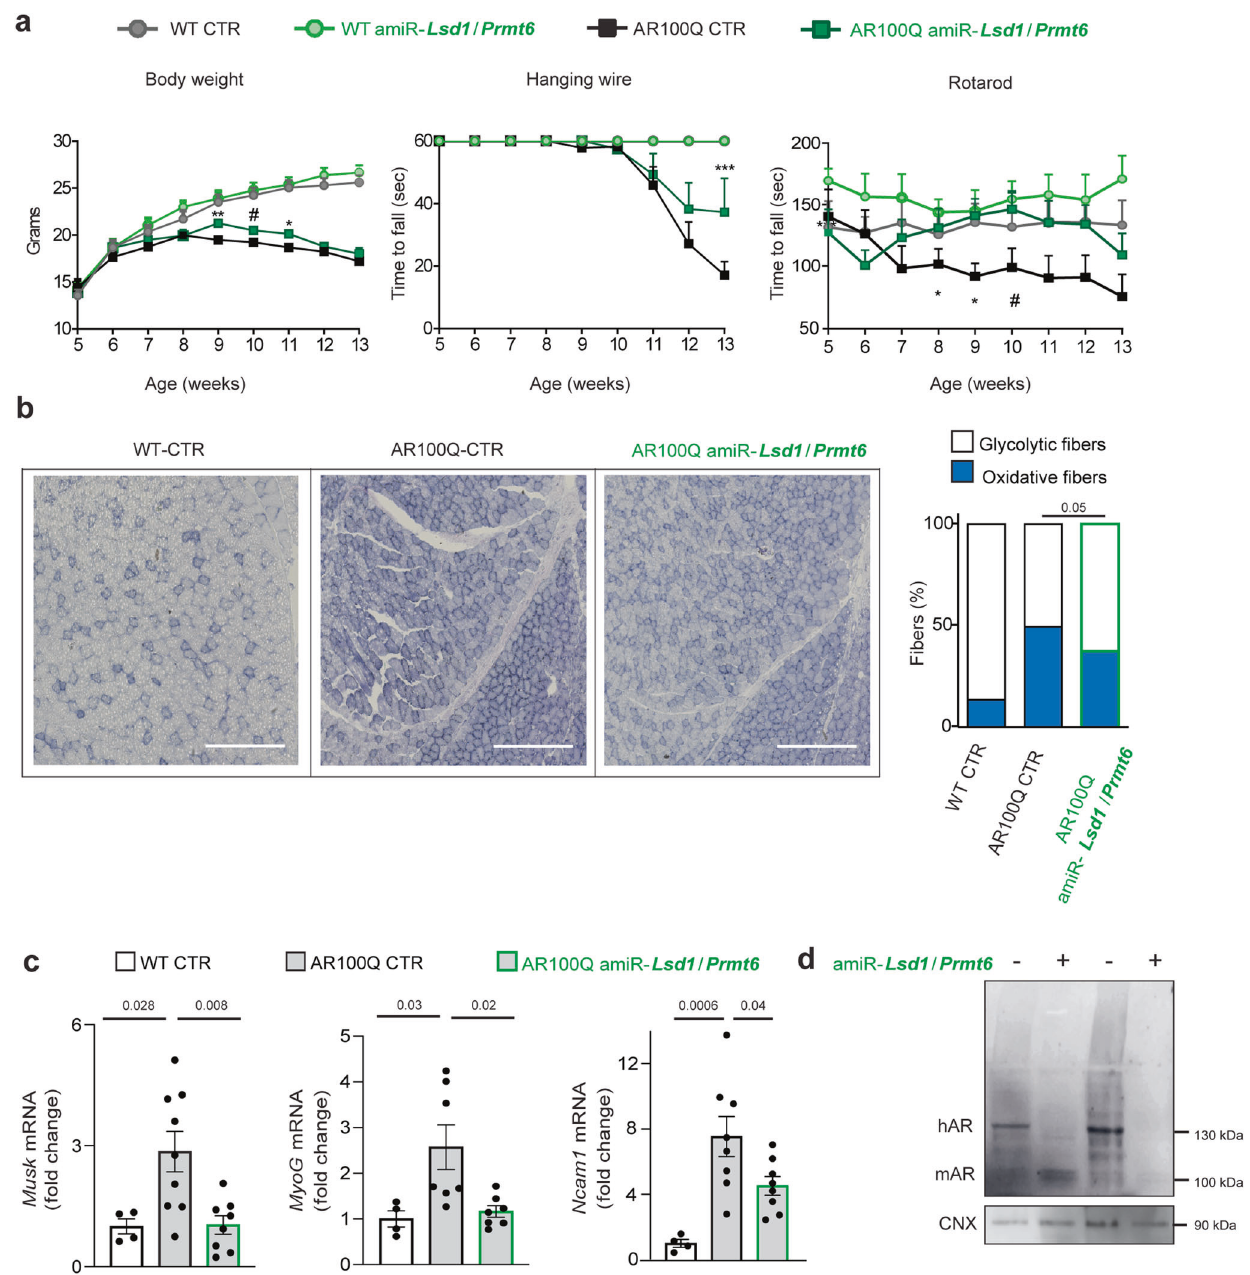
Fig.8|Silencingof Lsd1 and Prmt6